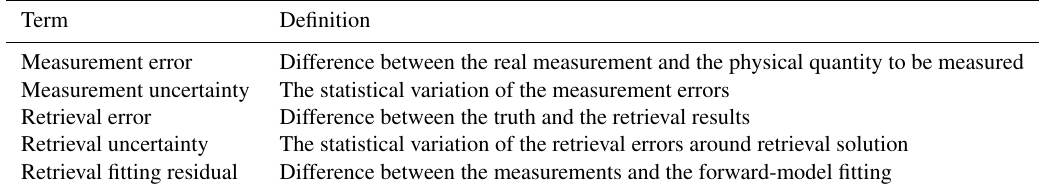
Table 2. Error and uncertainty definitions. Term